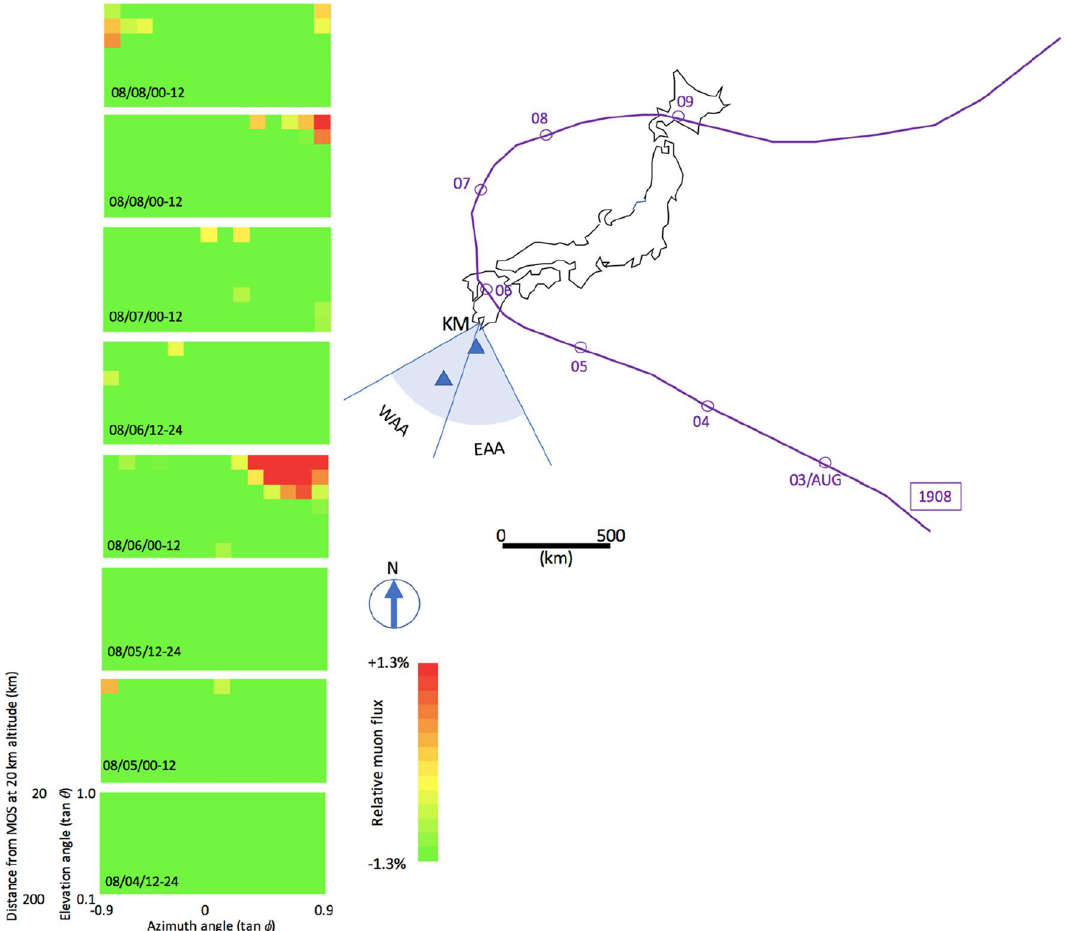
Figure 14. Time-sequential muographic images. The eight images show the muon flux variations observed every 12 h between 12:00 August 4, 2019, and 12:00 August 8, 2019. The horizontal width of these images corresponds to the shaded area indicated on the map on the right side. The meteorological history of T-1908 is also shown. Triangular symbols indicate the BP stations (Yakushima Station is in the north and Naze Station in the south). The symbol KM indicates the location of Kagoshima Muograph. WAA and EAA respectively indicate the eastern azimuthal angle region and the western azimuthal angle region used in Fig. 11. HKMT drew the map with Microsoft PowerPoint software and HKMT drew the image with Microsoft PowerPoint software and holds the